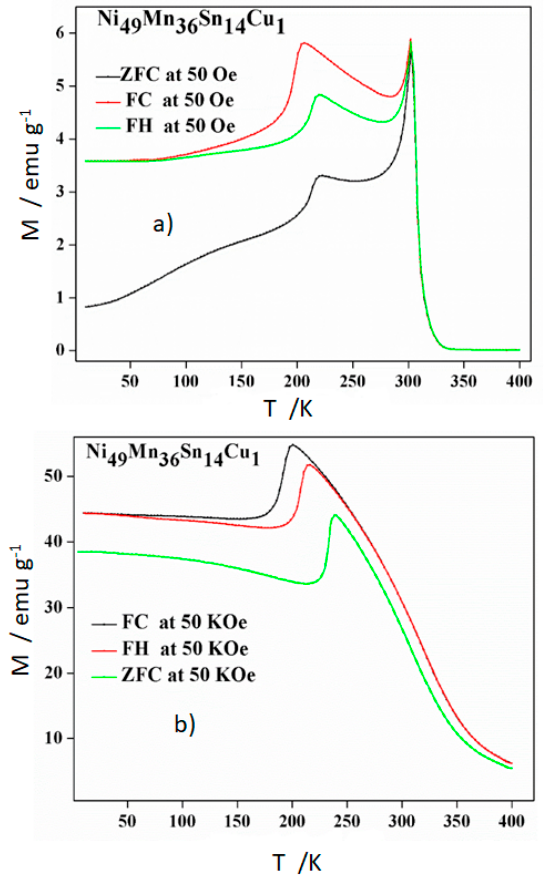
Figure 6. ZFC, FH and FC thermomagnetic measurements of alloy Ni 49 Mn 36 Sn 14 Cu 1 . ( a ) 50 Oe and ( b ) 50 KOe.